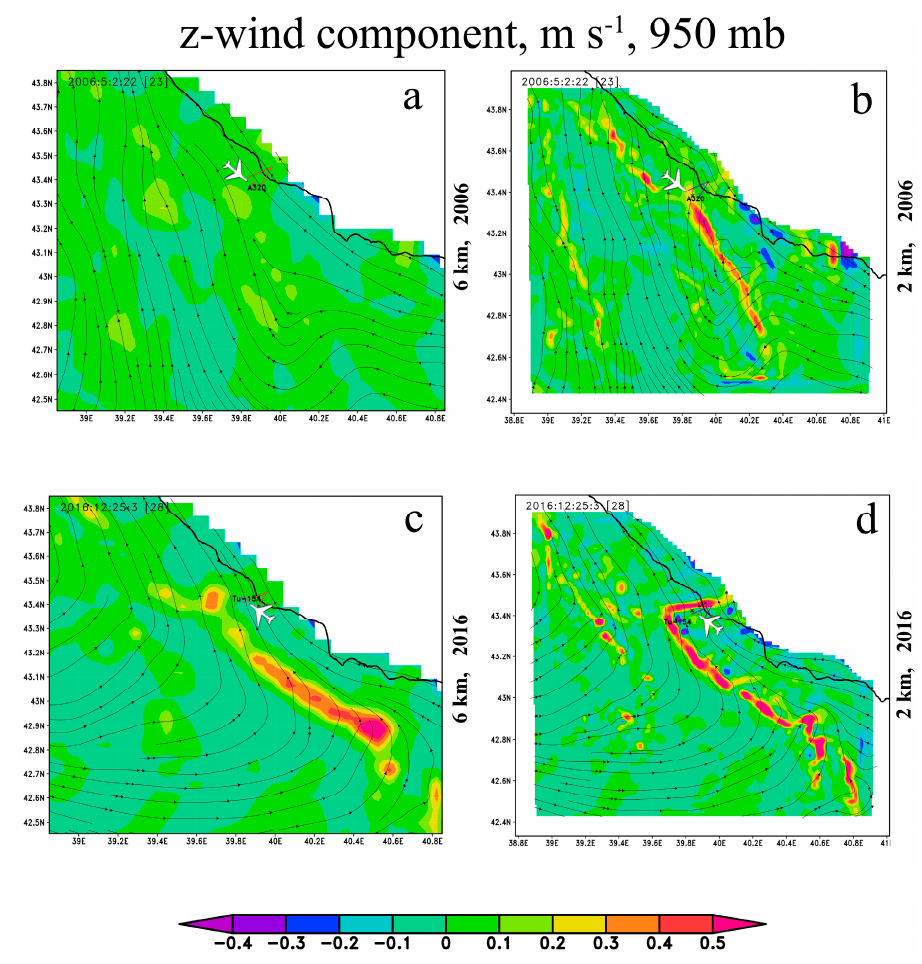
Figure 3. The z-wind speed at a 950 hPa altitude for model resolutions of 6 km ( a , c ) and 2 km ( b , d ) for the A320 ( a , b ) and Tu-154 ( c , d ) crash sites. The white area corresponds to the underground model level.